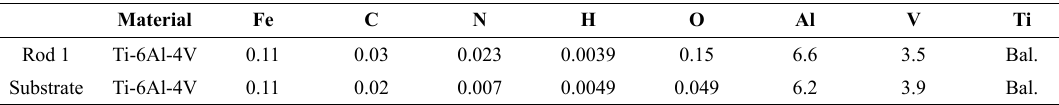
Table 1. Chemical composition (in